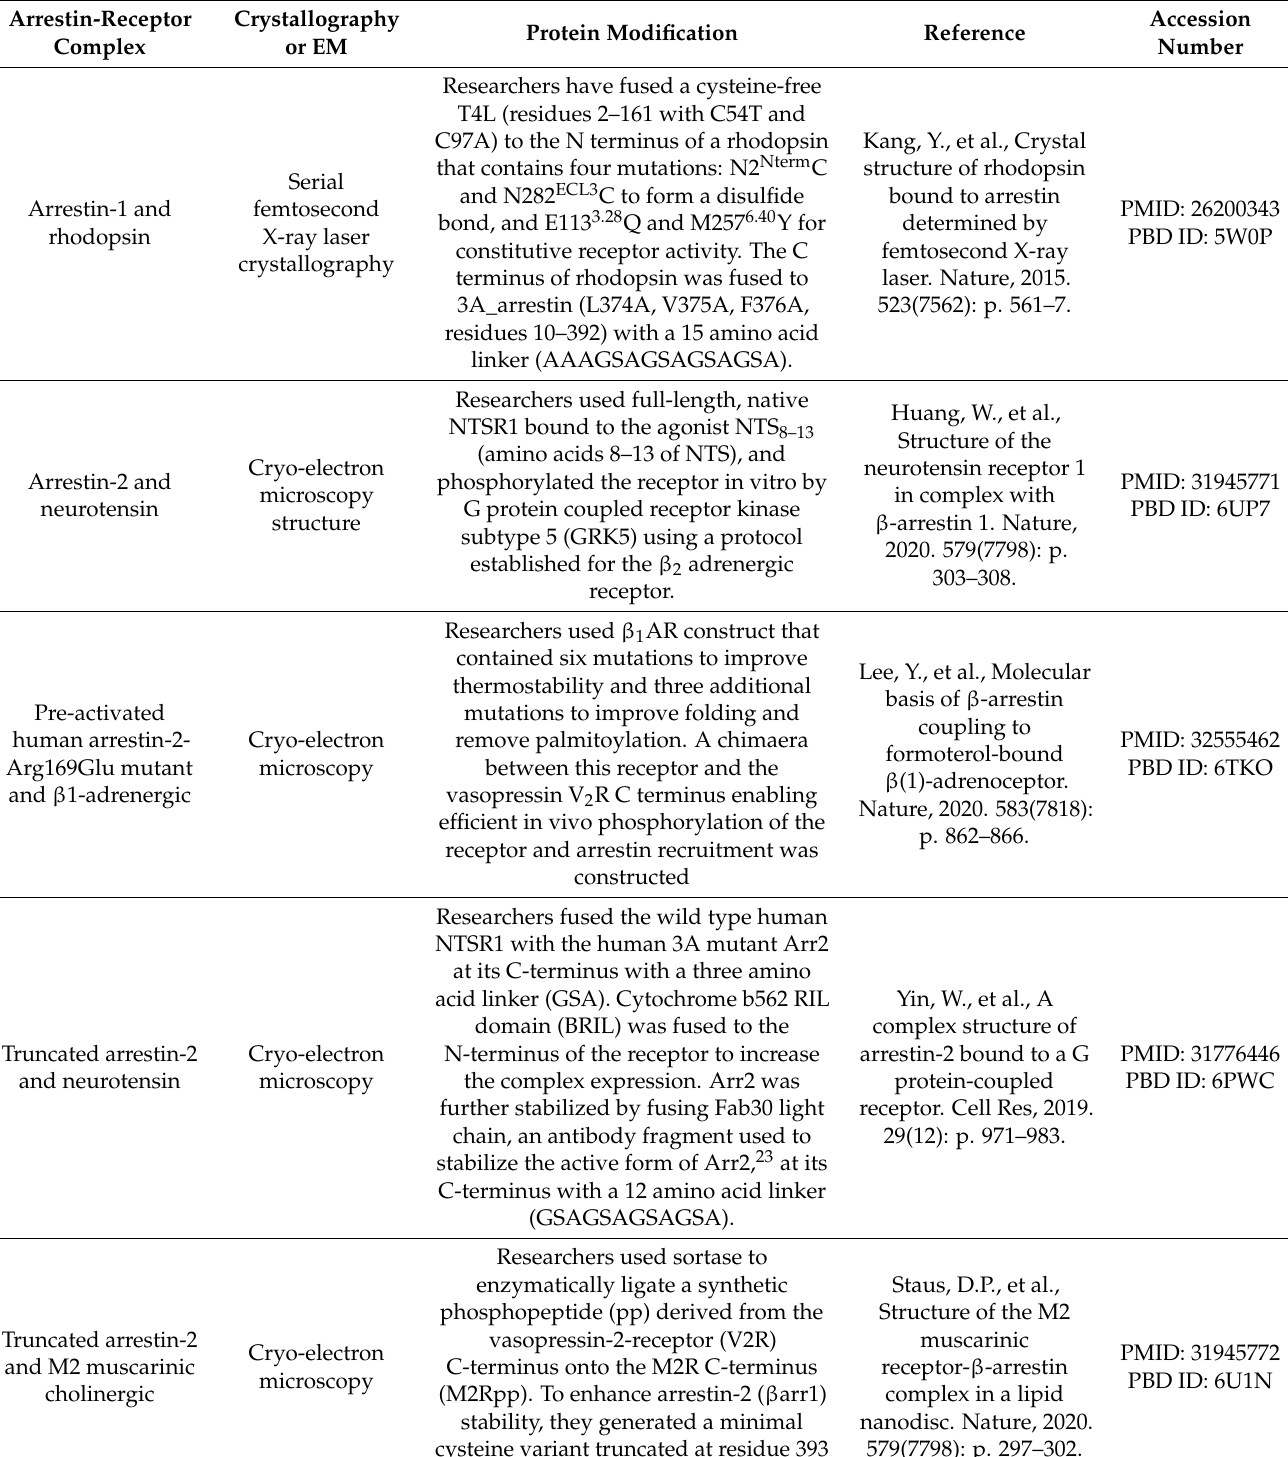
Table 1. Solved crystal structures of activated